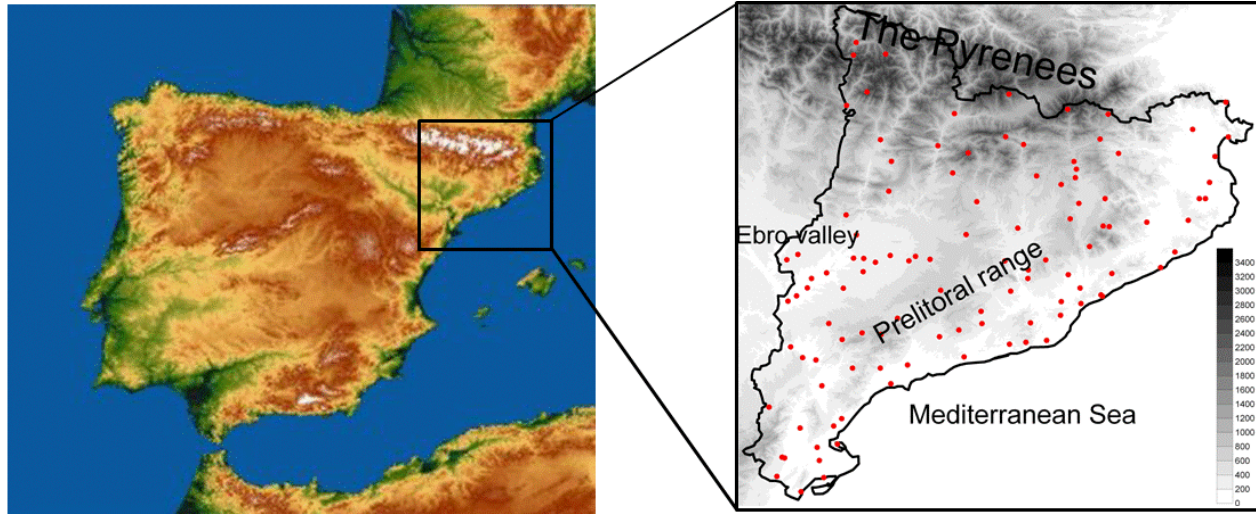
Figure 1. (a) Iberian Peninsula (b) Catalonia, red dots are SMC automatic weather 563 Fig. 1. (a) Iberian Peninsula; (b) Catalonia, red dots are SMC automatic weather stations. 564